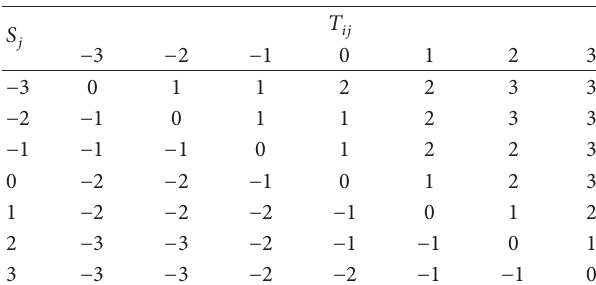
Table 2: The control enquiry table of precise data after system